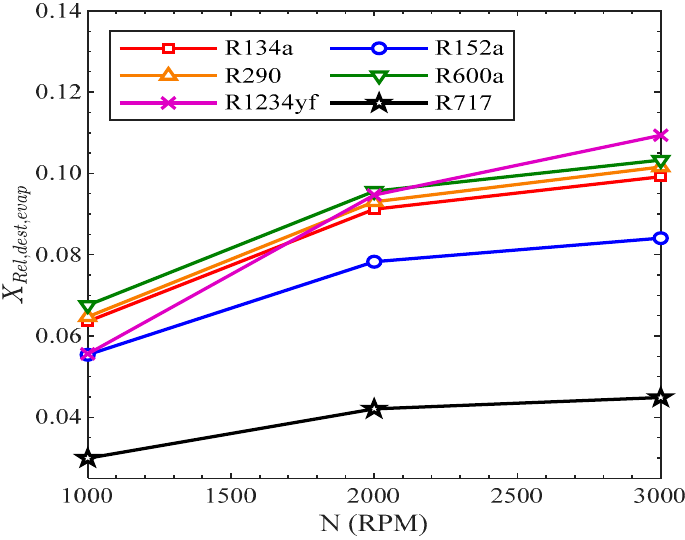
Figure 16 . Relative exergy destruction of evaporator vs. compressor speed .